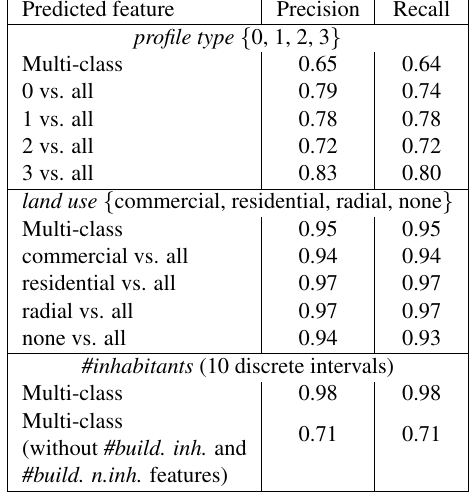
Table 1. The evaluation of the segment feature prediction is performed by a multi-class- and one-against-all-classification.